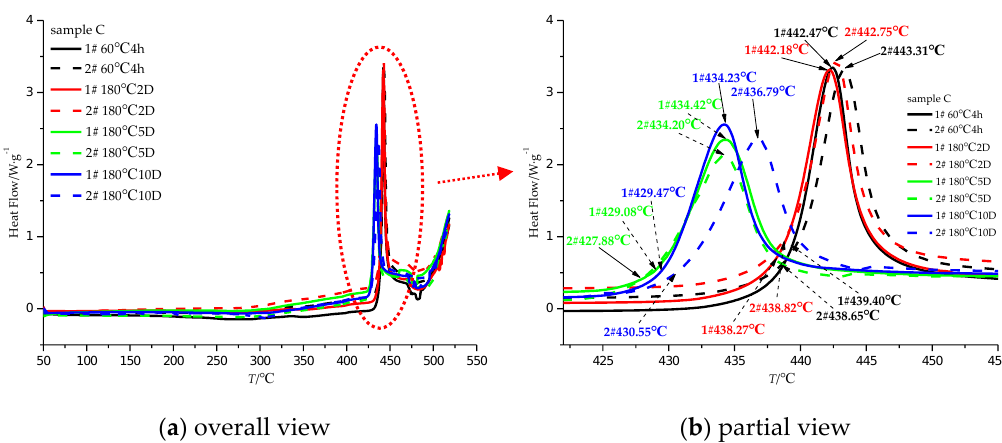
Figure 9. DSC curves of sample C after exposure to 60 °C for 4 h and 180 °C for 2 – 10 days. From the DSC curve of the ignition composition of Mg/TeO 2 , it can be seen that there were two reaction peaks in the samples: the pre-reaction peak and the main reaction peak. Before 380 °C, there was no endothermic/exothermic reaction; the exothermic pre-reaction took place at 381 °C to 470 °C, and the initial reaction temperature was 381 °C to 439 °C. The main reaction peak temperature was more than 500 °C, and the initial reaction temperature of the pre-reaction was more than 200 °C